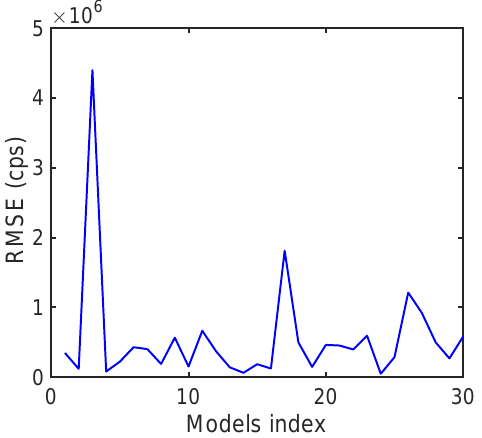
Figure 5. Root mean square error of all 30 surrogate models. The test set consists of 10 5 different sources not included in the training